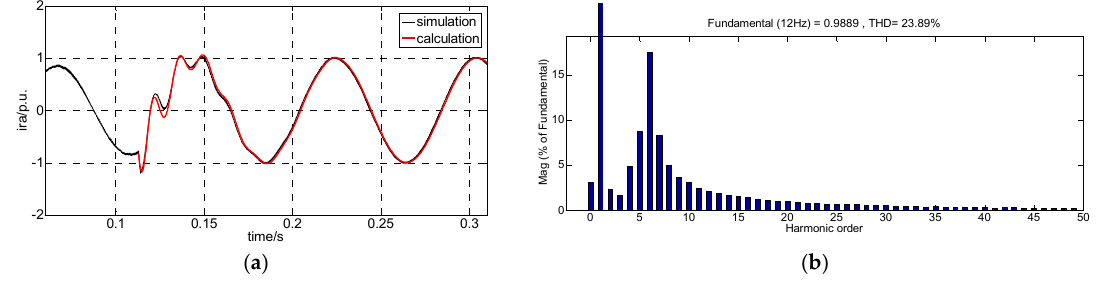
Figure 9. Rotor short-circuit current and its frequency spectral analysis: ( a ) comparison between simulated and calculated waveform; ( b ) frequency spectral analysis.